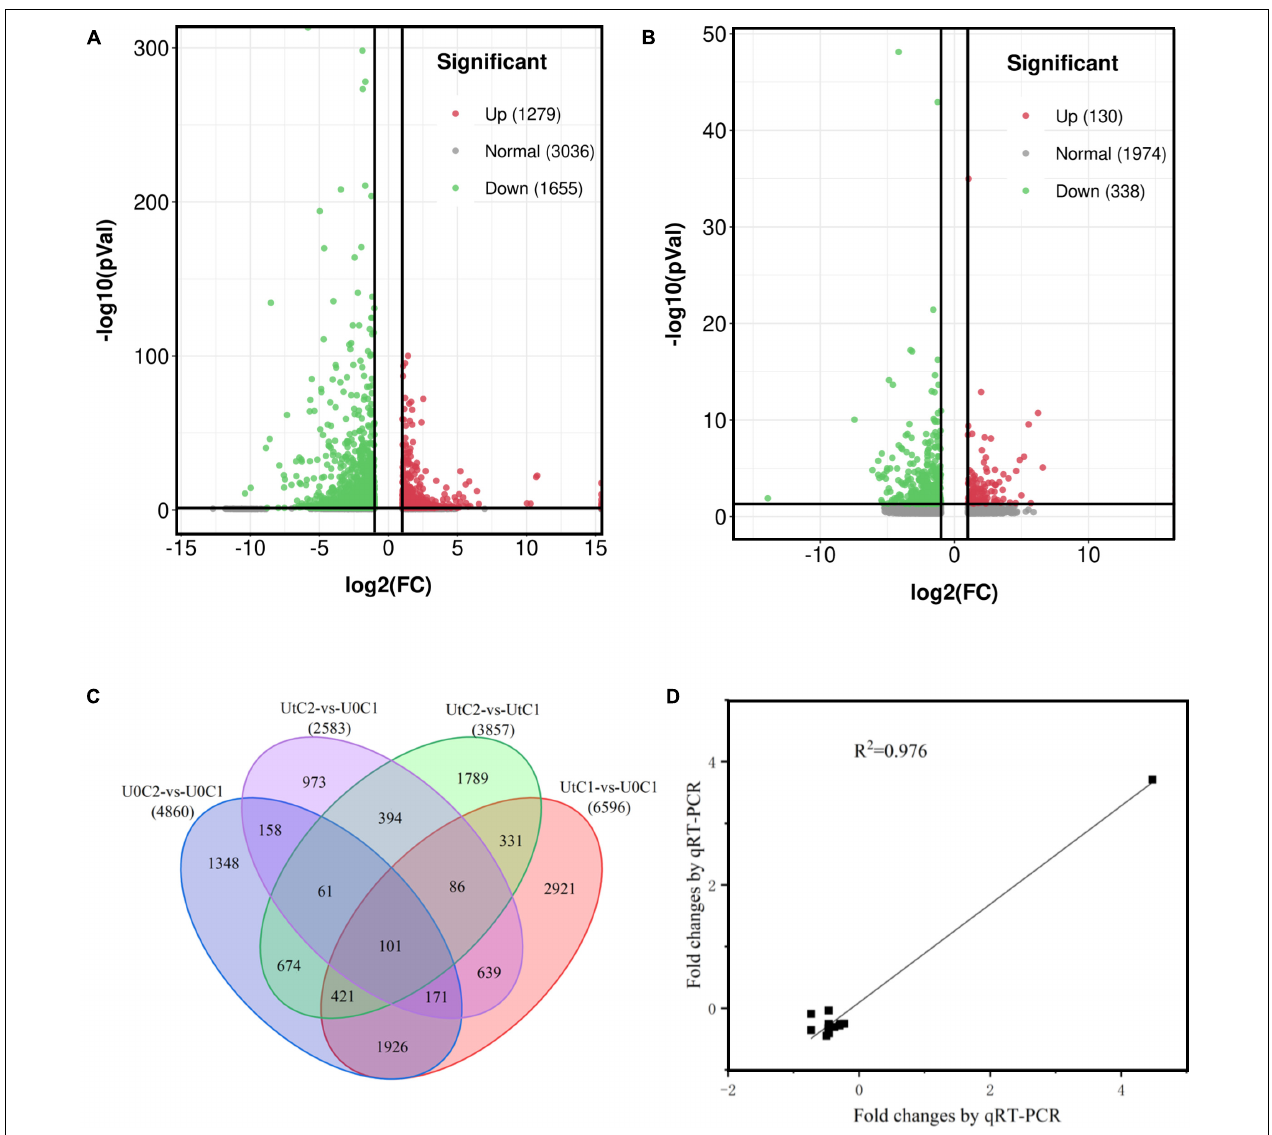
FIGURE 7 | Annotation and differentially expressed genes (DEGs) of the Angelica sinensis transcriptome. (A,B) Volcanic plots of the upregulated and downregulated genes of Angelica sinensis in two cultivars under enhanced UV-B radiation and natural light. (C) Unigene Venn diagrams for each group. (D) Correlation analysis between qRT-PCR and RNA-seq results of six